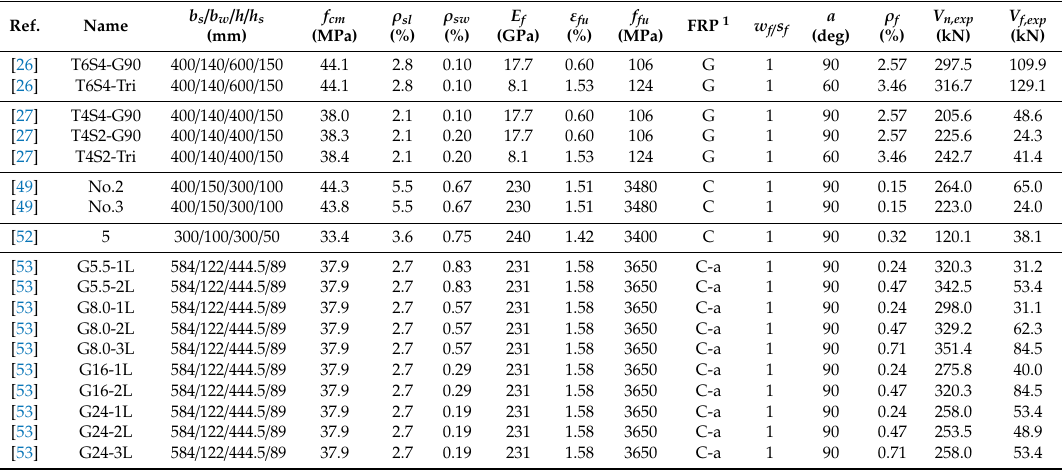
Table A1. Properties of the retrofitted T-beams with EB-FRP continuous U-jackets and stirrups of the database.